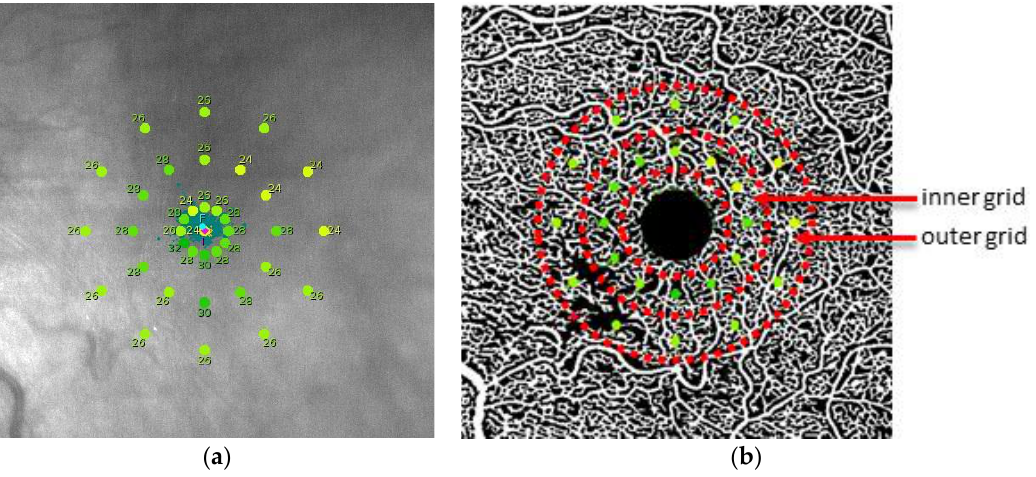
Figure 3. ( a ) Output MAIA microperimeter grid on I.R. retinal image. Red circle indicates grid 1° ( b ) MAIA microperimeter grid overlapped onto Binarized image of the superficial capillary plexus. Red arrows indicate Inner grid 2.5° and Outer grid 5°.